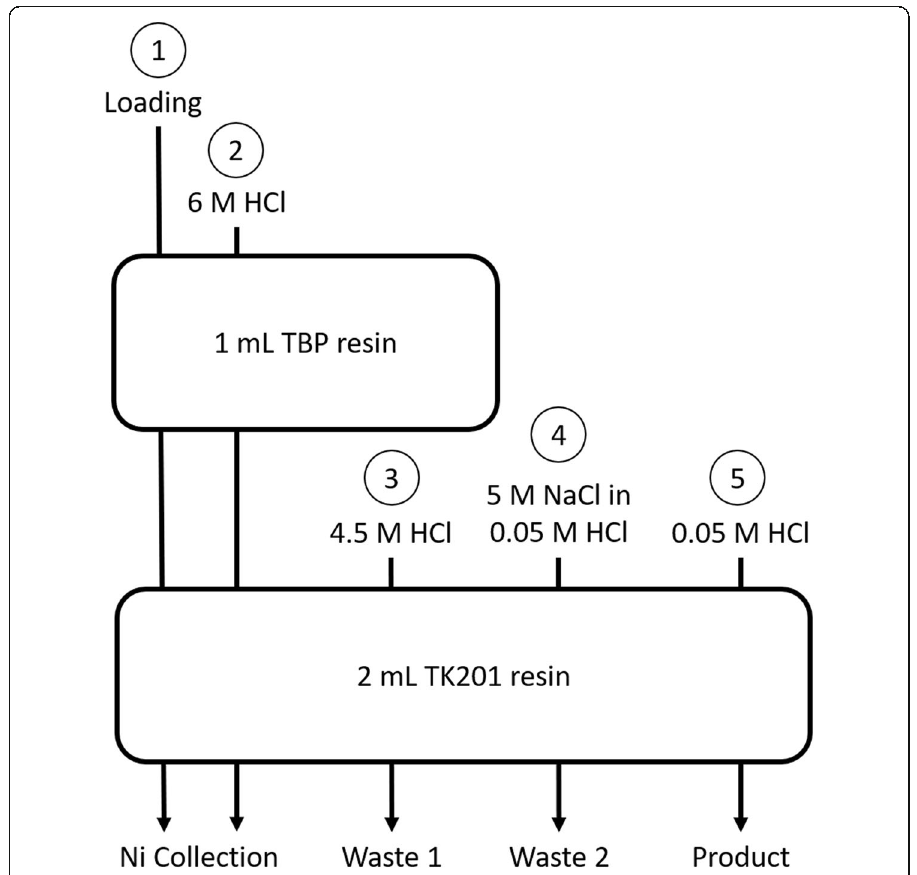
Fig. 1 Two-column approach for 61 Cu separation. Process steps described